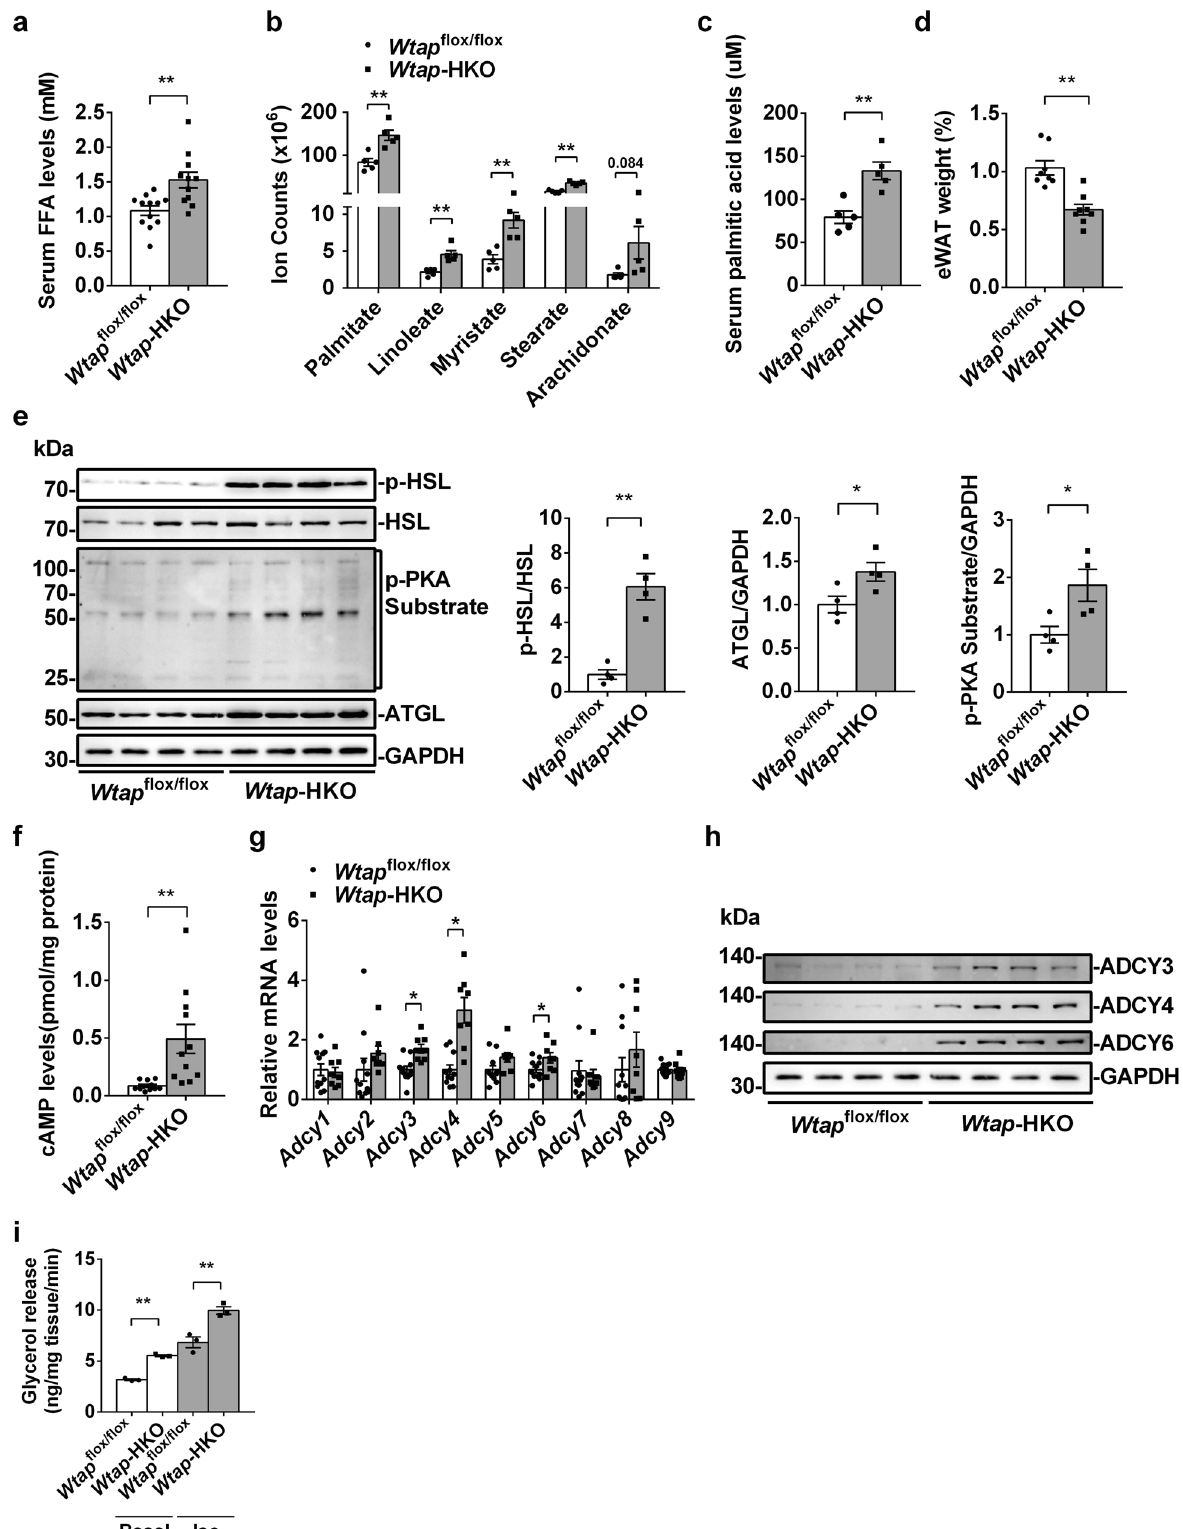
(Supplementary Fig. 13a, b). ATAC-seq data analysis identi fi ed 15,903 upregulated peak-related genes and 16,042 downregulated peak- related genes (Supplementary Data 3). Next, using motif analysis software HOMER, we found several transcription factor (TF) binding motifs. The binding motifs of four TFs (Fosl2, Fra1/2, Jun-AP1) were differentially open in the livers of Wtap -HKO mice, whereas the